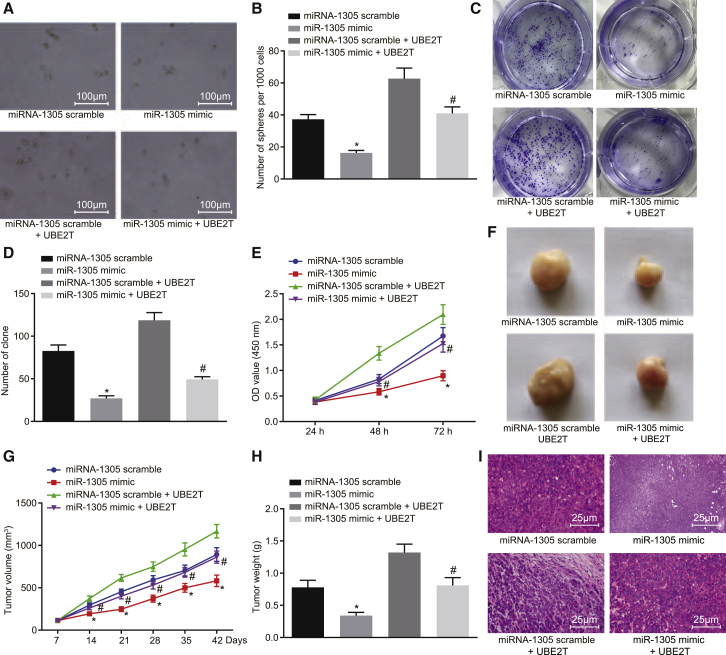
Upregulated miR-1305 Reduced LCSC Self-Renewal, Tumorigenesis, and Tumor Growth by Downregulating UBE2T(A) The sphere formation of LCSCs transfected with miR-1305 mimic with or without UBE2T (100×). (B) The quantitative analysis of (A). (C) The colony formation of LCSCs transfected with miR-1305 mimic with or without UBE2T. (D) The quantitative analysis of colony formation ability in (C). (E) The proliferative ability of LCSCs transfected with miR-1305 mimic with or without UBE2T, assessed by CCK-8 assay. (F) The observation of tumors in nude mice. (G) The tumor volume in nude mice injected with miR-1305 mimic-transfected or miR-1305 mimic + UBE2T-co-transfected LCSCs measured by Vernier caliper. (H) The tumor weight in nude mice injected with miR-1305 mimic-transfected or miR-1305 mimic + UBE2T-co-transfected LCSCs. (I) The pathological characteristics of tumor tissues in nude mice observed by H&E staining (400×). miR-1305 scramble group, LCSCs transfected with miR-1305 scramble or nude mice inoculated with miR-1305 scramble-transfected LCSCs; miR-1305 mimic group, LCSCs transfected with miR-1305 mimic or nude mice treated with miR-1305 mimic-transfected LCSCs; miR-1305 scramble + UBE2T group, LCSCs co-transfected with miR-1305 scramble and UBE2T or nude mice inoculated with co-transfected LCSCs; miR-1305 scramble + UBE2T group, LCSCs co-transfected with miR-1305 mimic and miR-1305 scramble or nude mice inoculated with co-transfected LCSCs. *p < 0.05 versus LCSCs transfected with miR-1305 scramble or nude mice inoculated with or miR-1305 scramble-transfected LCSCs; #p < 0.05 versus LCSCs co-transfected with miR-1305 scramble and UBE2T or nude mice inoculated with co-transfected LCSCs. Statistical data were described as mean ± SD. Data were analyzed by one-way ANOVA, and data in (E) and (G) were compared by repeated-measures ANOVA. The experiment was repeated 3 times independently (n = 6).